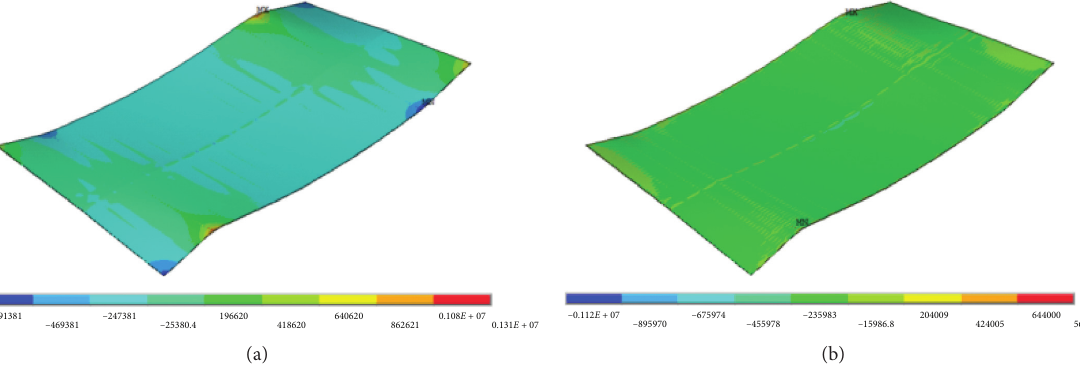
Figure 13: The stress diagram of the pavement layer under the most unfavorable torque of the random traffic flow. (a) The longitudinal stress diagram. (b) The transverse stress diagram. Table 3: Comparison of random traffic flow and lane load results.